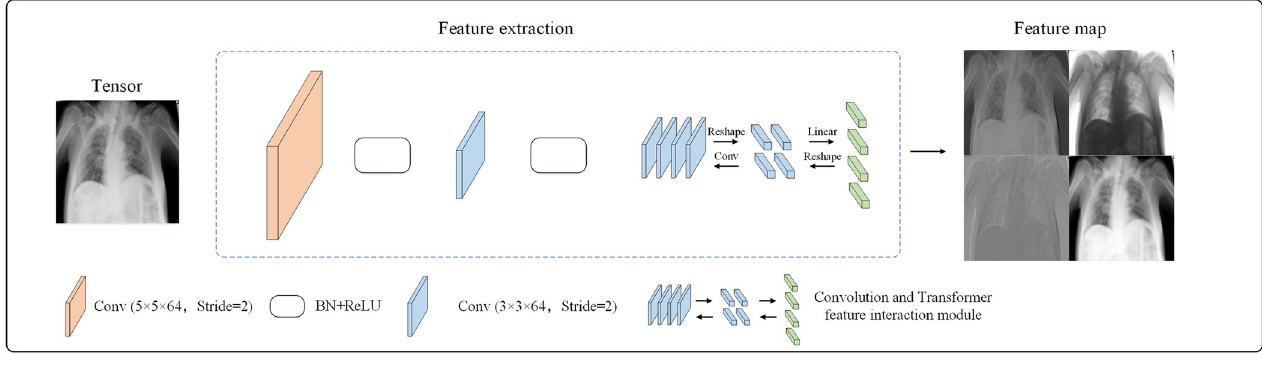
Fig 5. Feature extraction